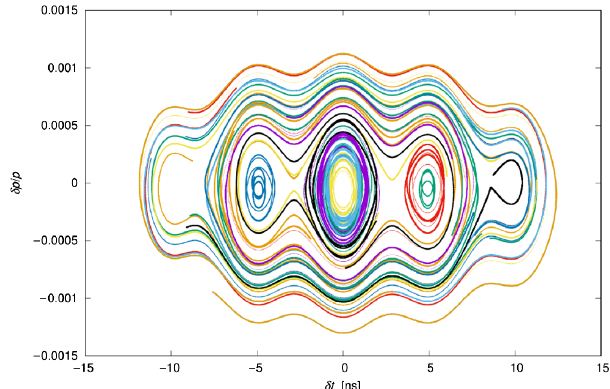
FIG. 35. Sample particle motion in longitudinal phase space over an initial 5000 turns spin and longitudinal stabilization phase, followed by 10,000 turn snake supplies ramp. Bunch length is about RHIC nominal 25 ns, momentum excursion is (cid:2) 10 − 3 .